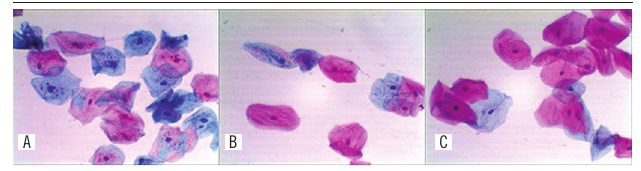
FigurE 2 − Staining classified as optimal in three fixation times A) seven days fixation; B) 30-minutes fixation; C) 15-minutes fixation.